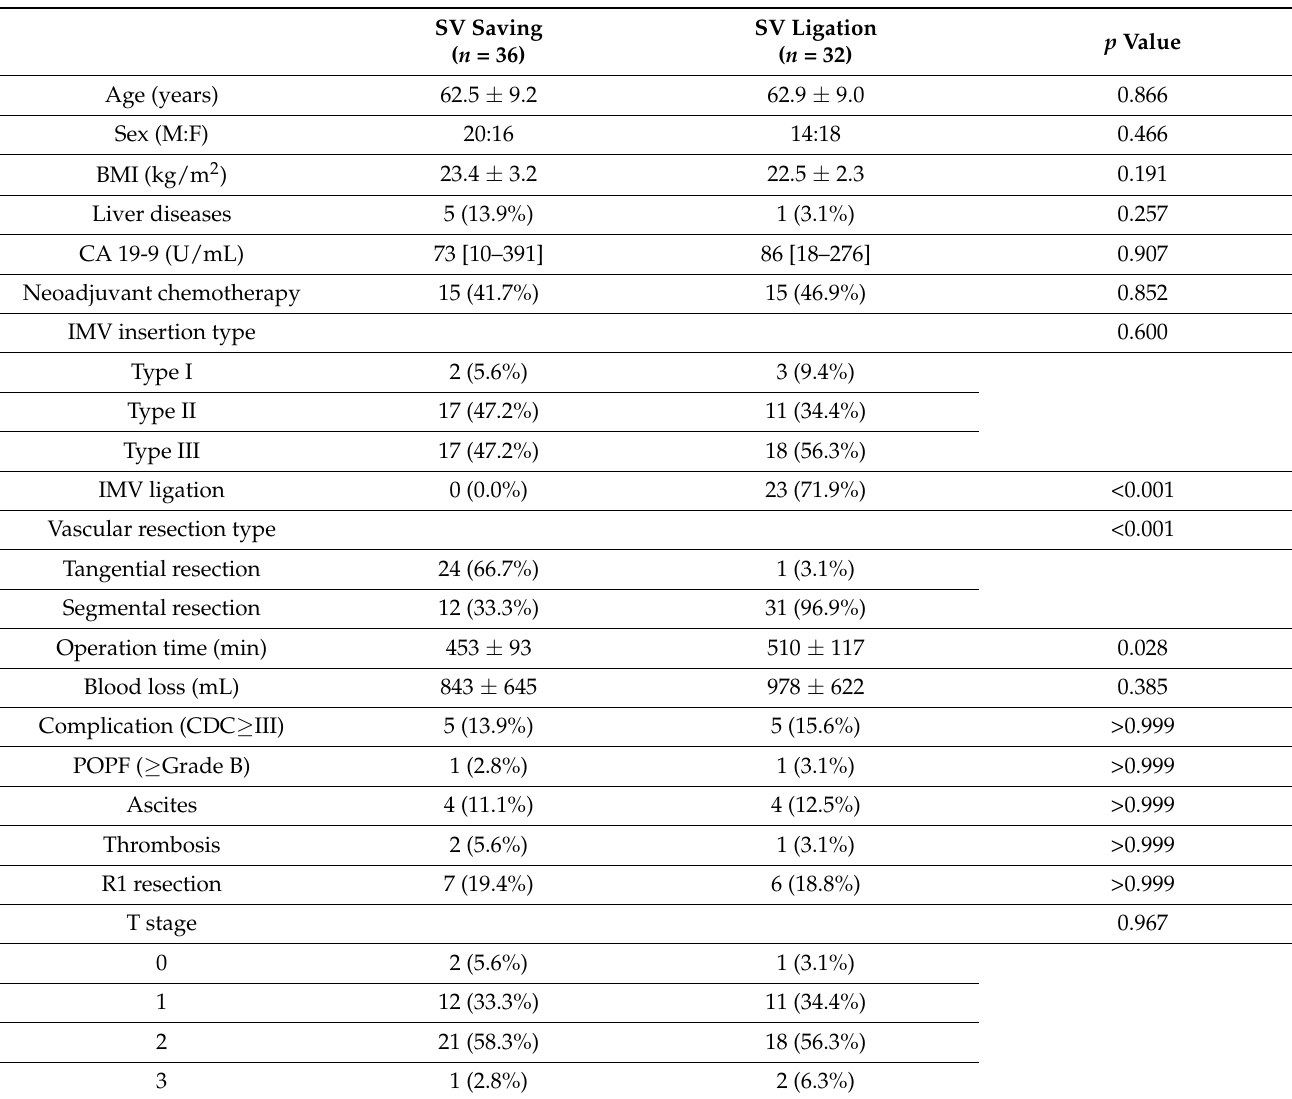
Table 3. Basal characteristics according to splenic vein